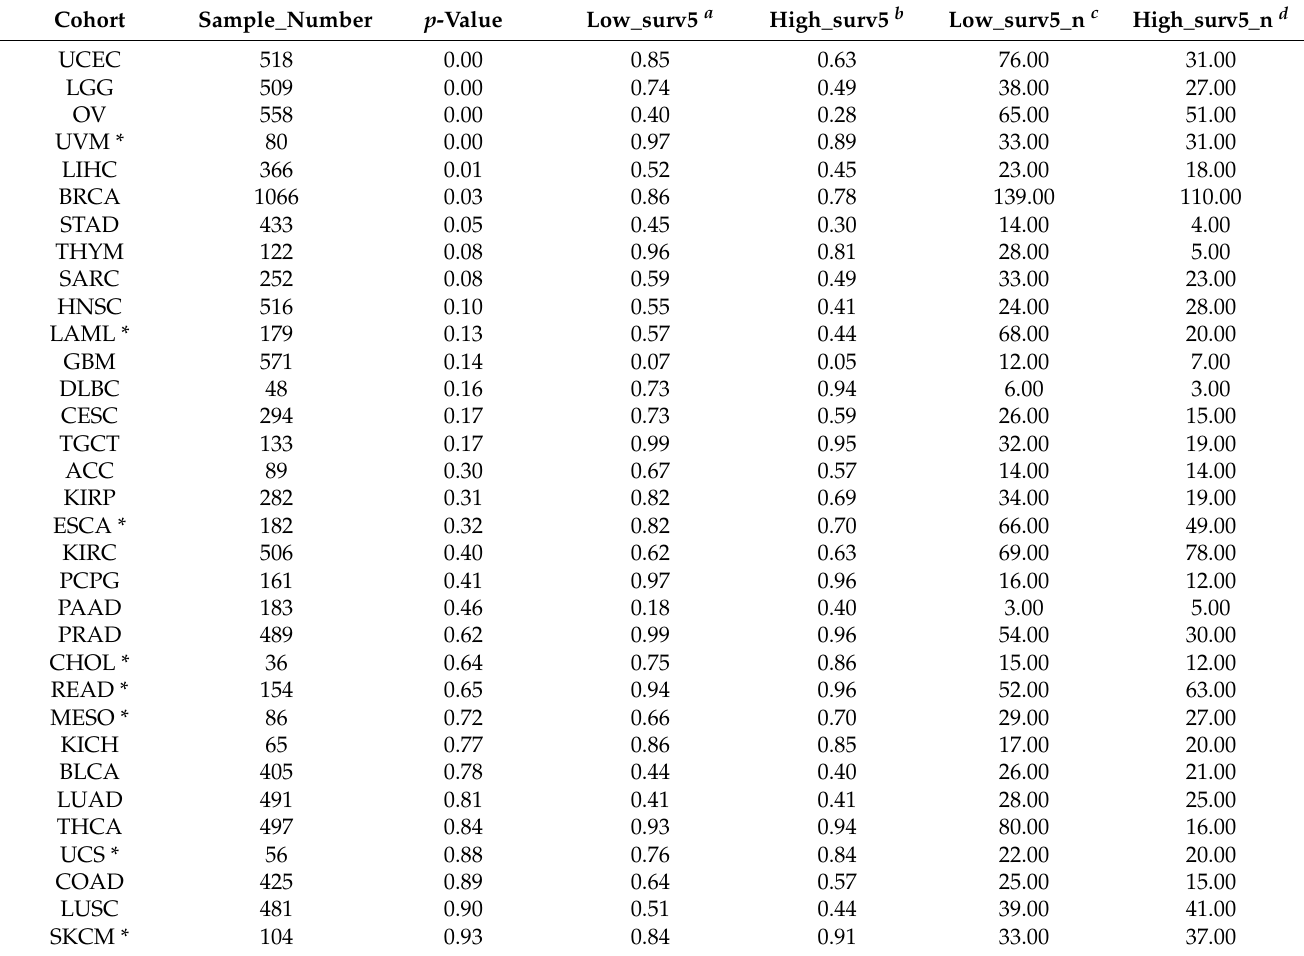
Table A1. Association between W-CIN and overall survival across cancer types.